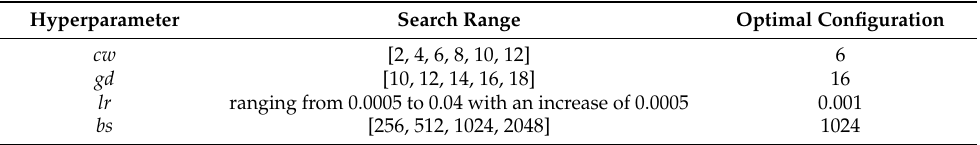
Table 2. The hyperparameter search range and optimal configuration of the Con-GRU